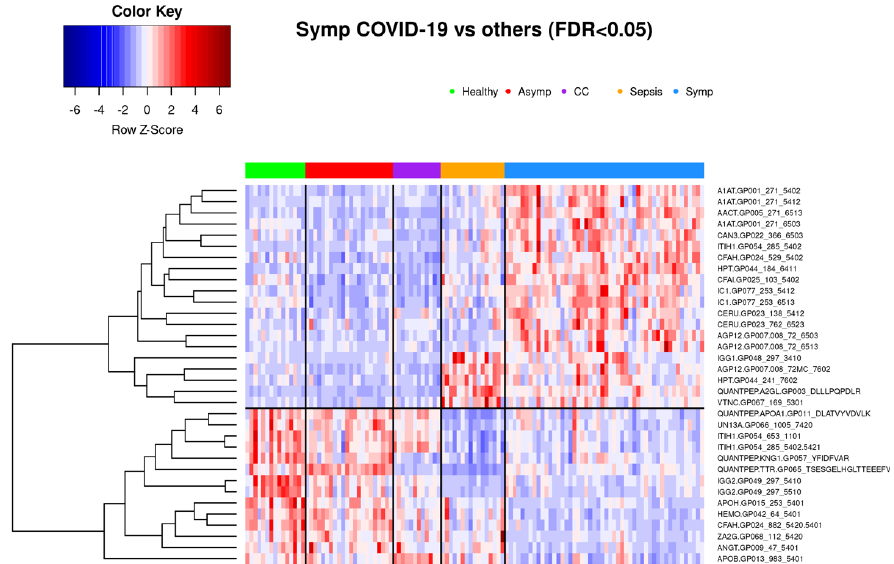
Figure 7. Thirty-four biomarkers that achieve FDR < 0.05 in differential expression analysis between symptomatic COVID-19 and all four of the other phenotype groups separately. Subjects are clustered into phenotype groups column-wise and hierarchically clustered row-wise. Row-wise Z-scores determine the color of each cell. CC: Common cold coronavirus.